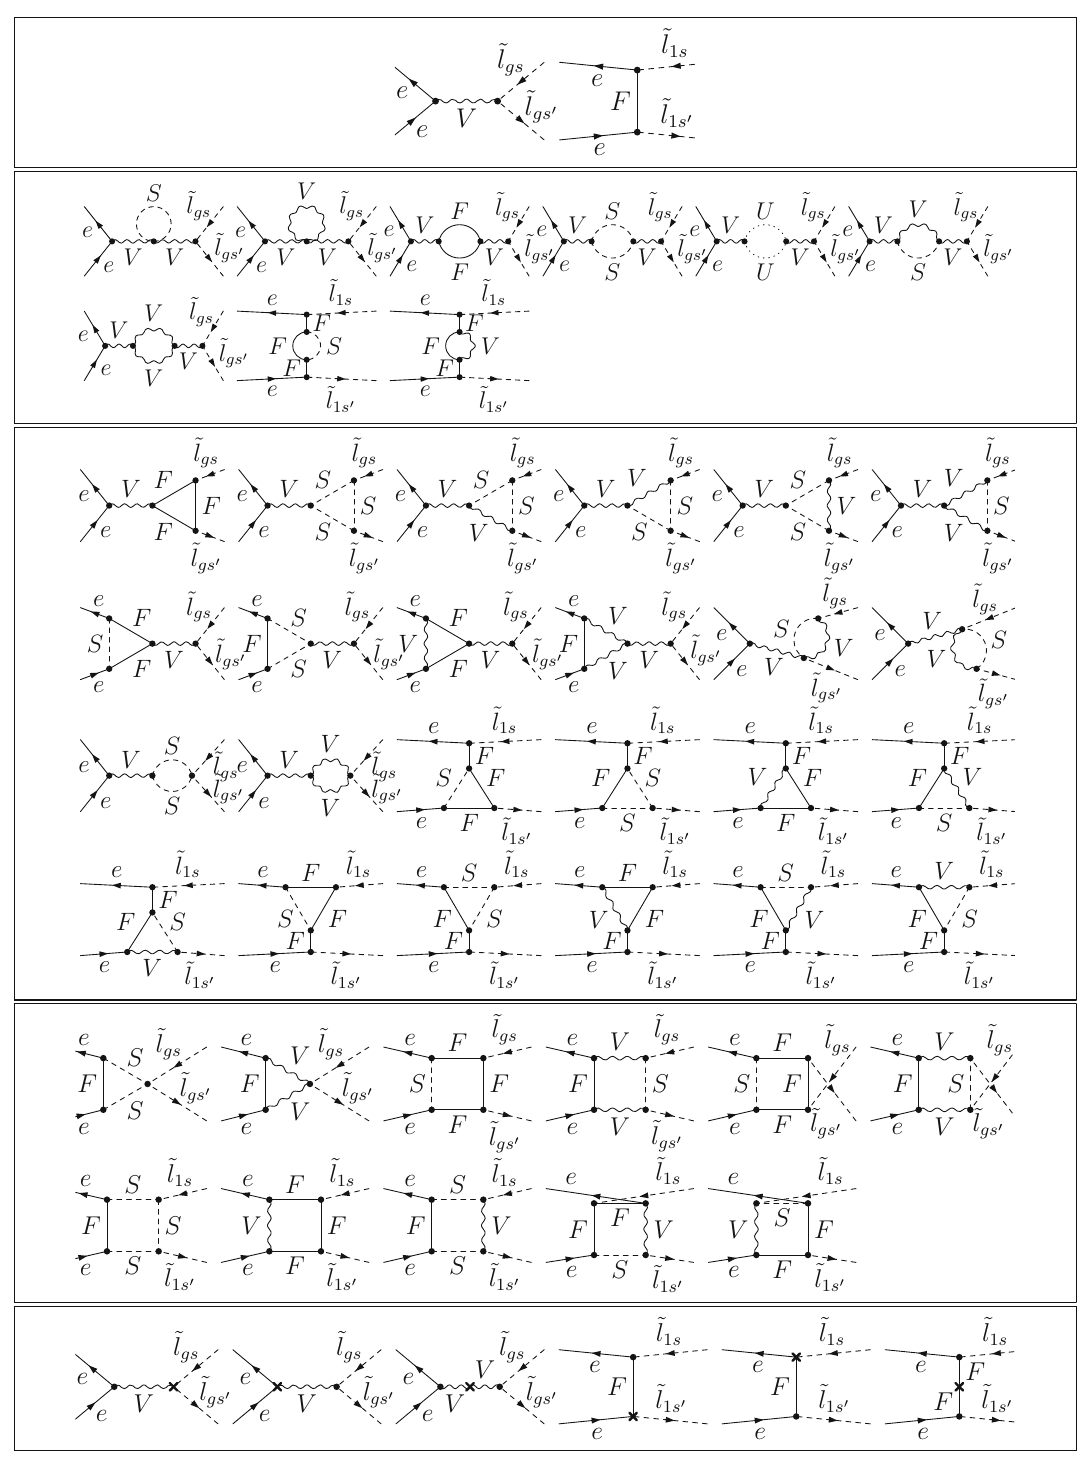
Fig. 1 Generic tree, self-energy, vertex, box, and counterterm dia- grams for the process e + e − → ˜ l gs ˜ l gs (cid:3) ( ˜ l gs = {˜ e gs , ˜ ν g }; g = 1 , 2 , 3 ; s , s (cid:3) = 1 , 2). The additional diagrams, which occur only in the case of first generation slepton production, are denoted with ˜ l 1 s .